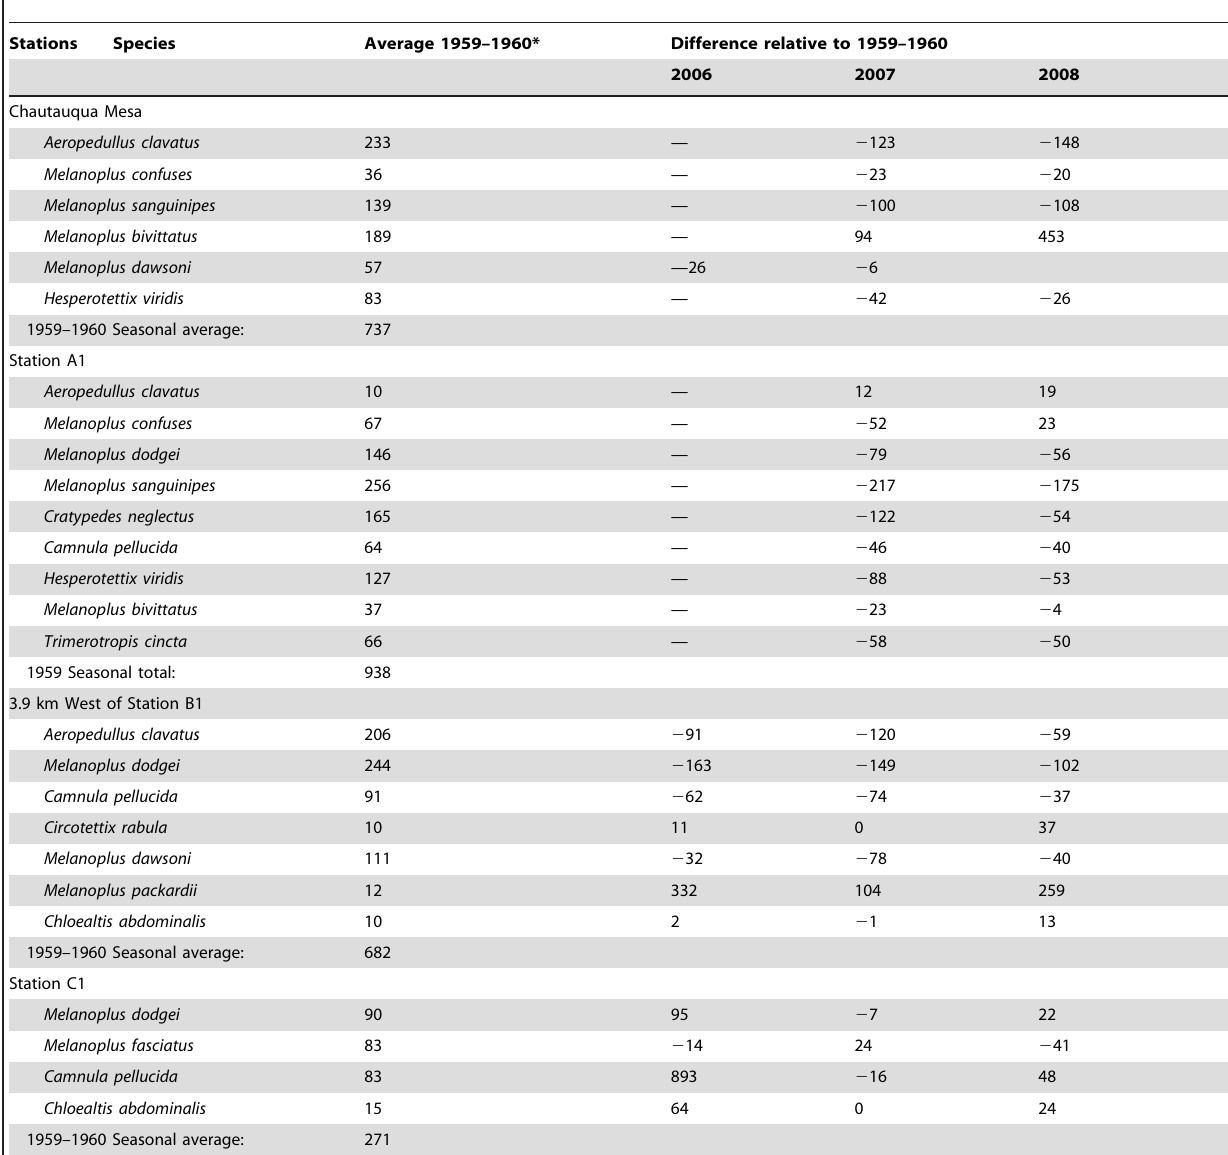
Table 1. The average number of individuals collected of each species at each site during the 1959–1960 surveys and the relative increase or decrease in abundance during the recent